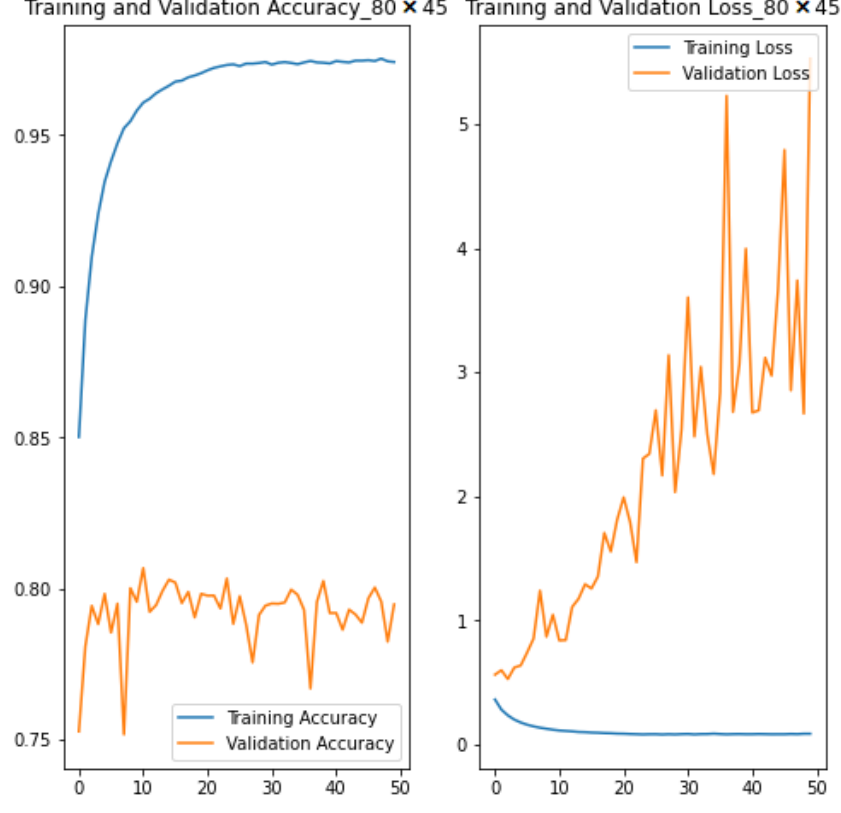
Figure 3. Training/validation loss and accuracy for image size 80 ×